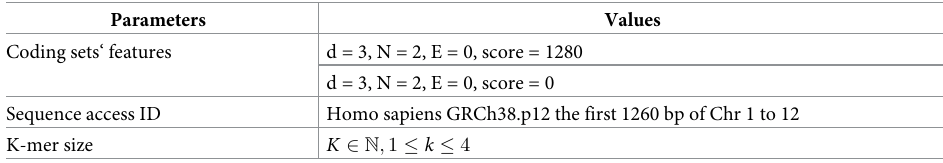
Table 12. Assumptions of k-mer counting